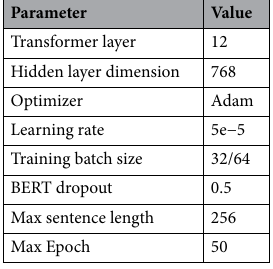
Table 2. Model parameters.